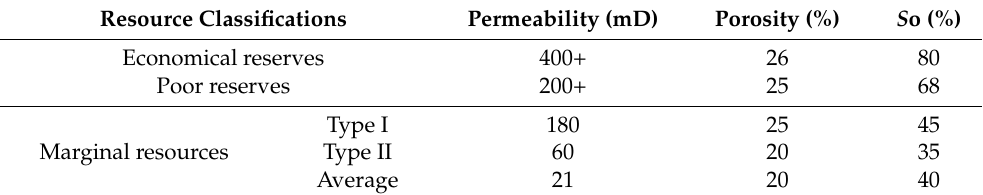
Table 1. Properties of different resource types. S o: initial oil saturation. The arithmetic average method is applied to calculate the permeability. Resource Classifications Permeability (mD)